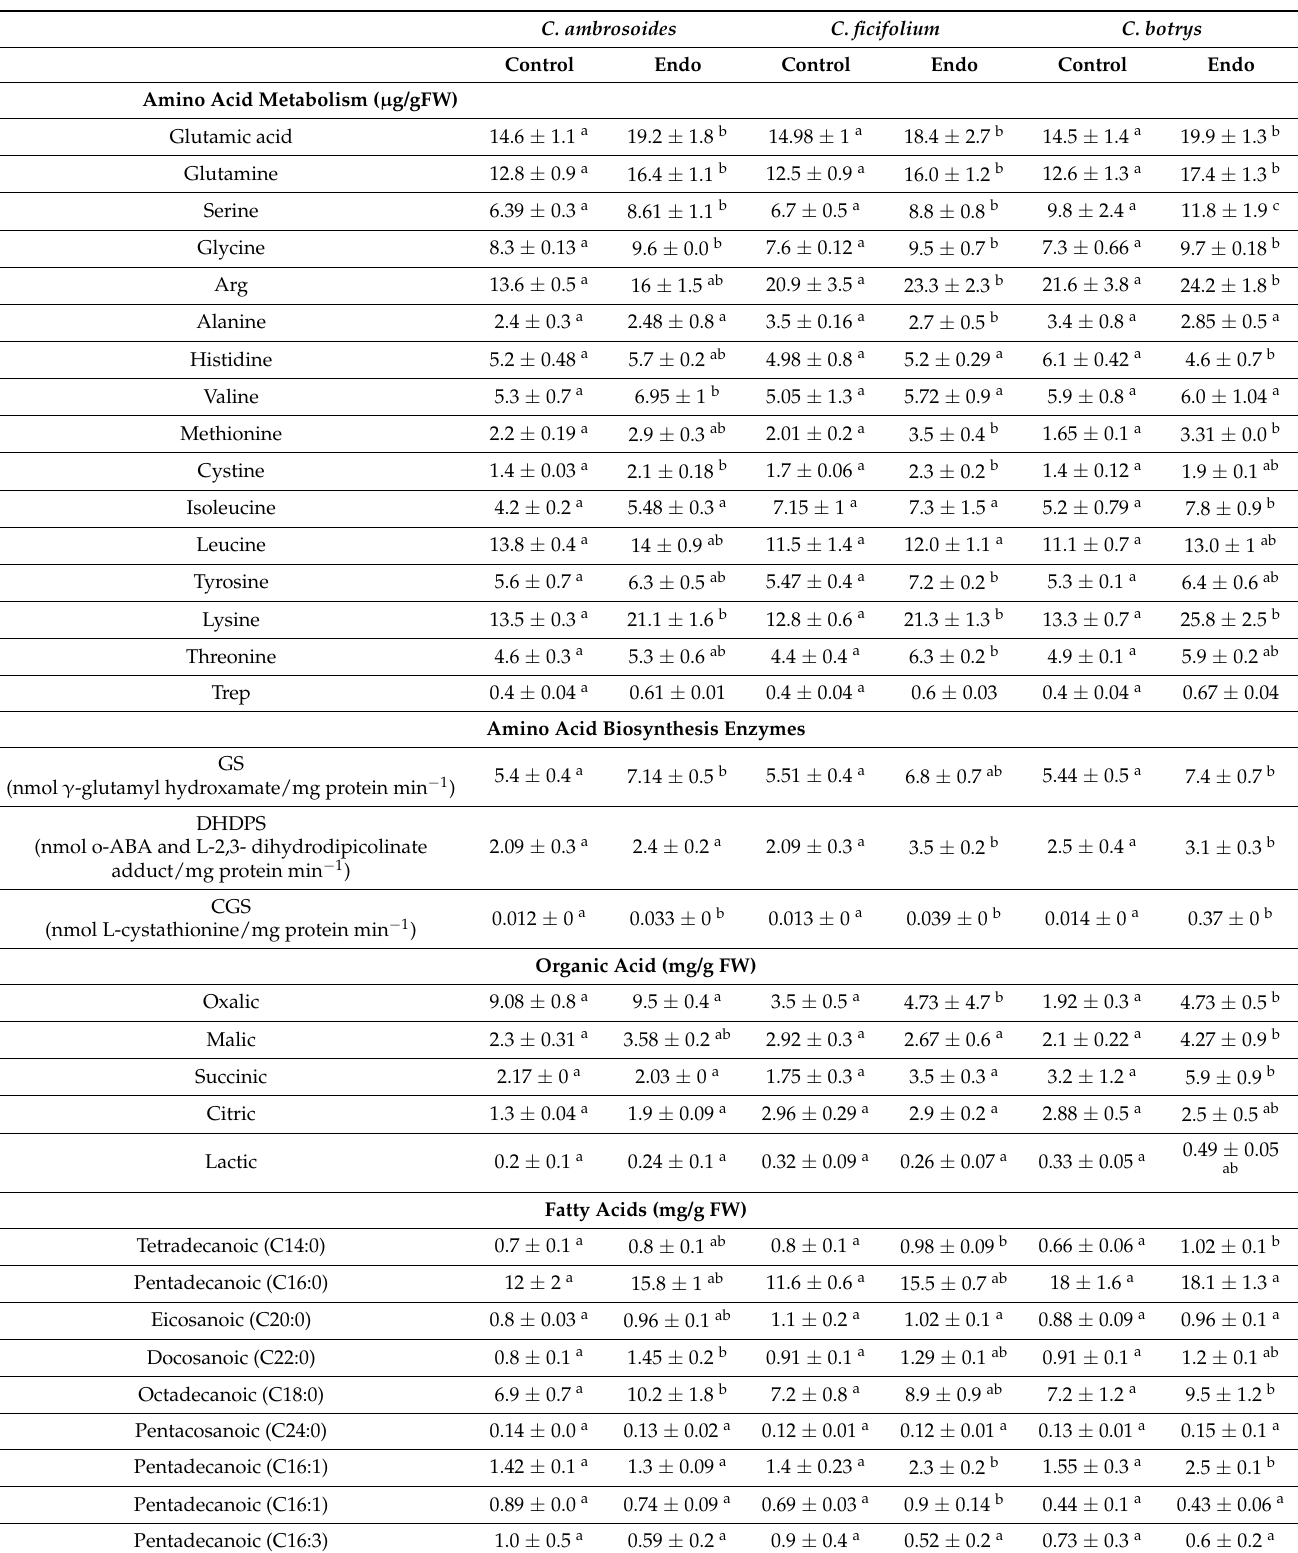
Table 4. Amino acids and amino acids-related enzymes, organic acids, and fatty acids of control and endophytic bacterial -treated Chenopodium ambrosoides, Chenopodium ficifolium, and Chenopodium botrys sprouts. Data are represented by the means of at least 3 replicates ± standard deviations. Different small letter superscripts (a, b) within a row indicate significant differences between control and endophytic bacterial